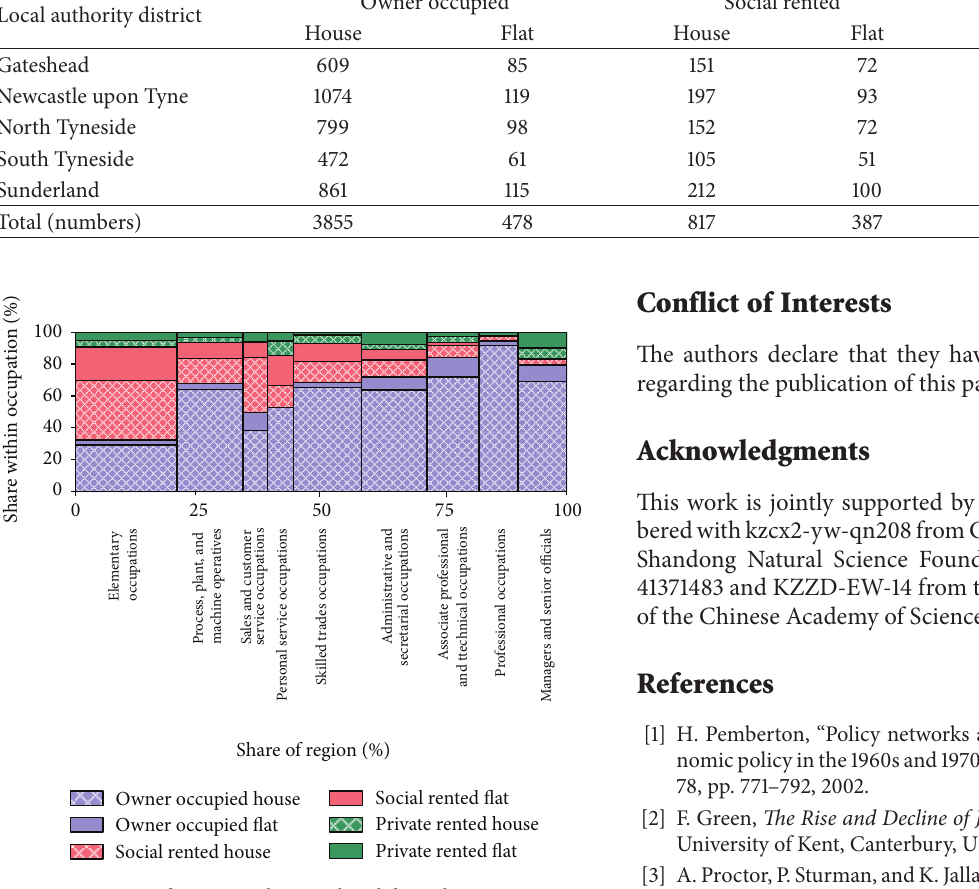
Figure 10: Type and tenure utilization breakdown by occupation in the Tyne and Wear region based on Labour Force Survey 2005